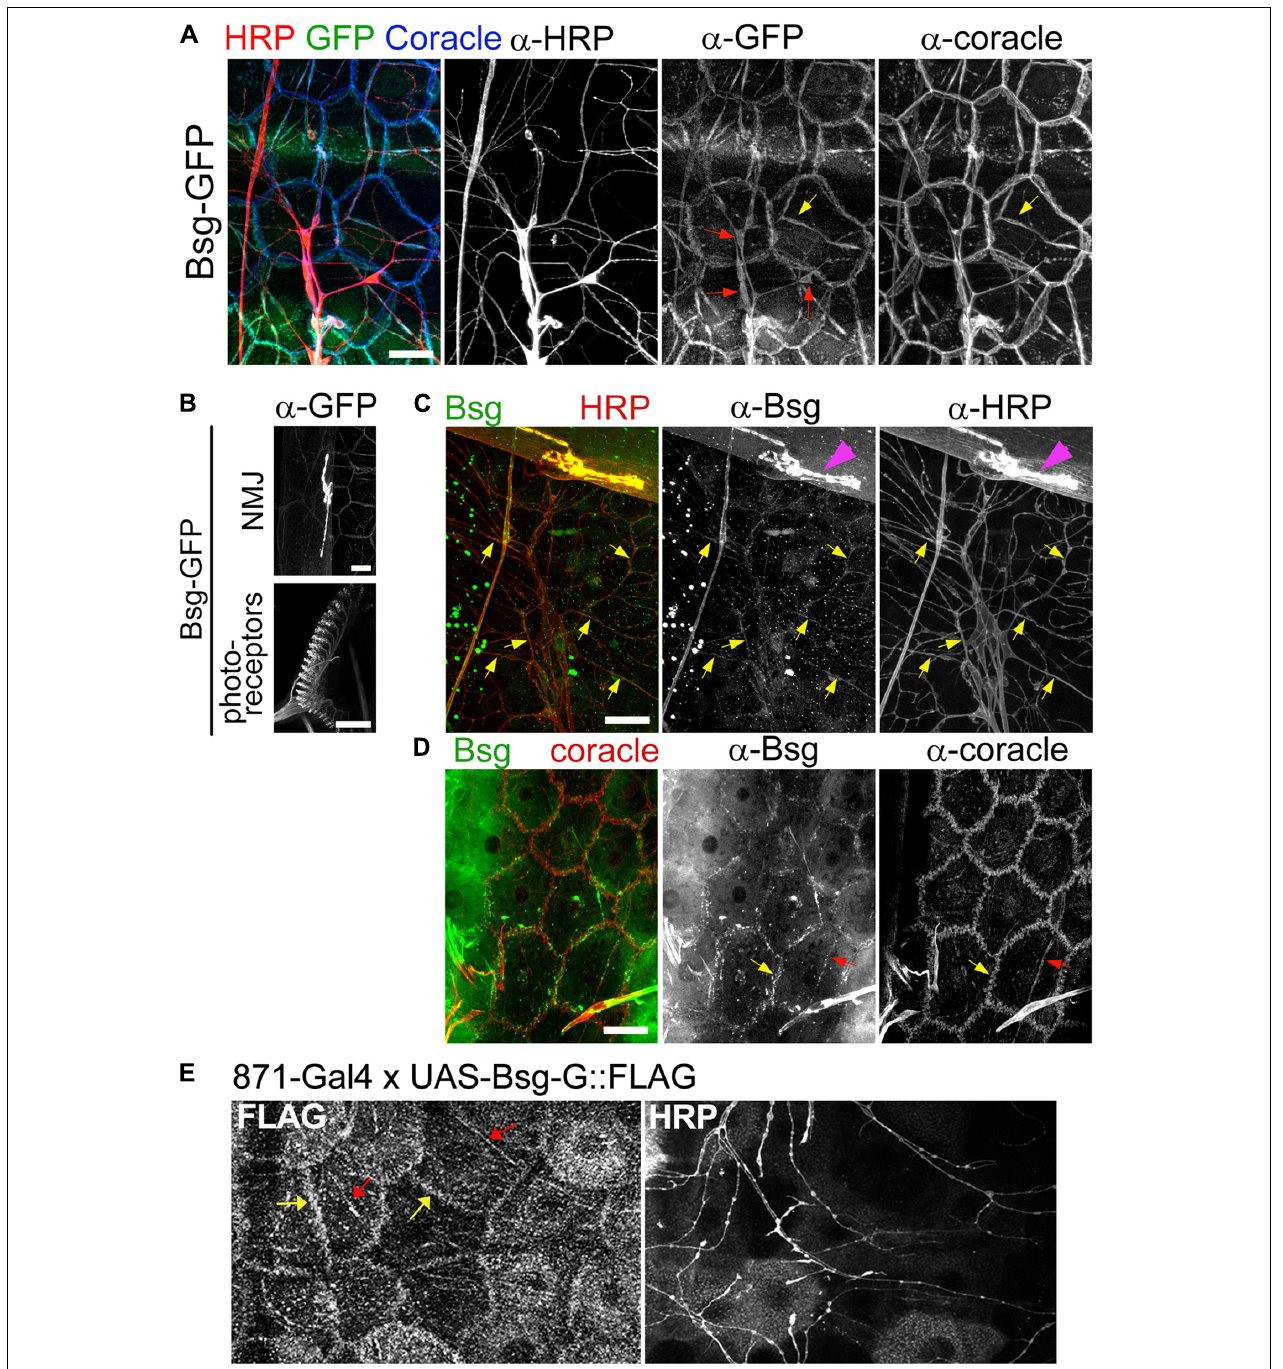
FIGURE 3 | Basigin is expressed in da neurons and their epidermal cell substrates. (A) Basigin::GFP expression in epidermal cells and da neurons in the Drosophila larval body wall at third instar stage. Basigin::GFP localized to soma (red arrows), axons and dendrites of neurons. In the epidermis, Basigin::GFP localized to cell borders and along dendrite segments (yellow arrows), overlapping almost completely with the septate junction resident protein Coracle. (B) Basigin::GFP in the larval NMJ and photoreceptors, two structures that have previously been shown to require Basigin for proper morphogenesis (Besse et al., 2007; Curtin et al., 2007). (C) w 1118 larvae were labeled with α -Bsg and α -HRP under standard immunohistochemical conditions. Basigin expression was observed in da neurons, with localization to dendrites (yellow arrows) and axons, and also in NMJ (magenta arrowheads), but epidermal expression was not detected. (D) When α -Bsg was applied to live tissue before fixing, Basigin was detected at cell borders (yellow arrows) and along dendrite segments that overlapped with α -Coracle staining (red arrows). (E) Expression of FLAG-tagged Basigin (UAS-Bsg-G) in the epidermis and staining with α -FLAG (left panel) and α -HRP (right panel) revealed Bsg-G localization at epidermal cell borders (yellow arrows) and tracking dendrite segments (red arrows), which is consistent with the observed epidermal GFP pattern of Basigin-GFP protein-trap lines. Scale bars, 25 µ m.